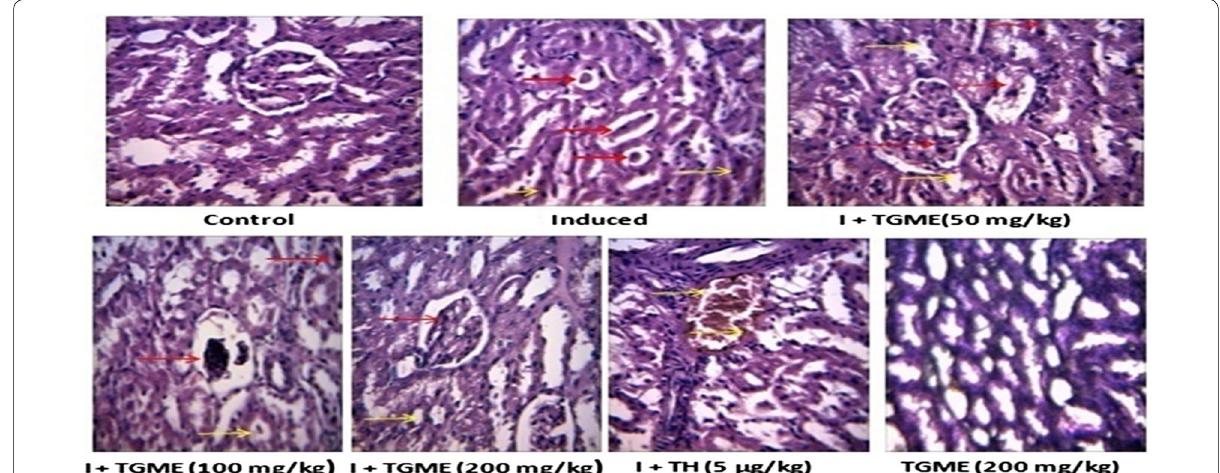
Fig. 19 Light microscopic architecture in the kidney section stained with hematoxylin and eosin (H&E): X100. TGME Triclisia gilletii aqueous methanolic extract, TH tamsulosin